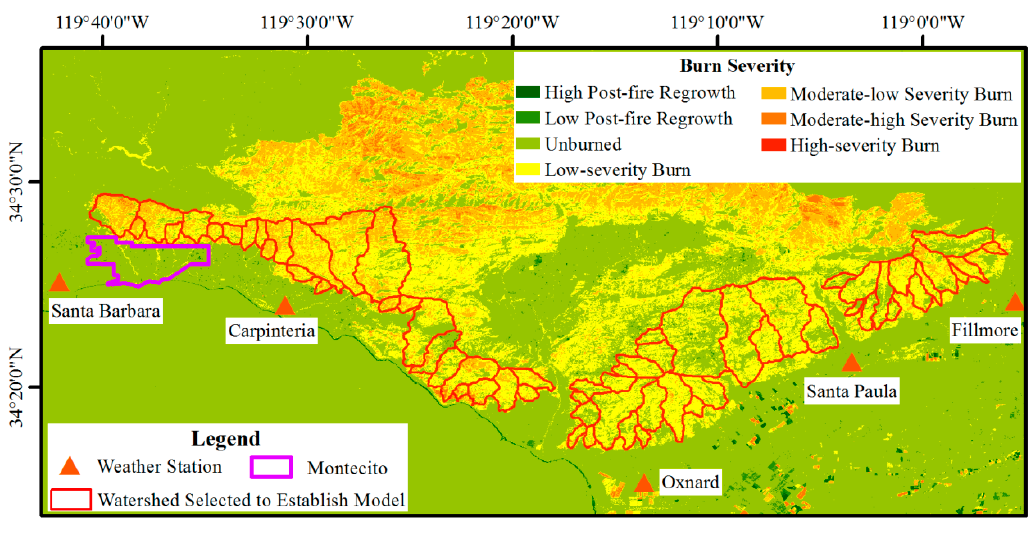
Figure 10. Burn severity affected by the Thomas Fire.